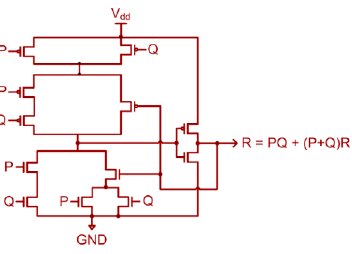
Figure 2. Static CMOS realization of a two-input Muller C-element.